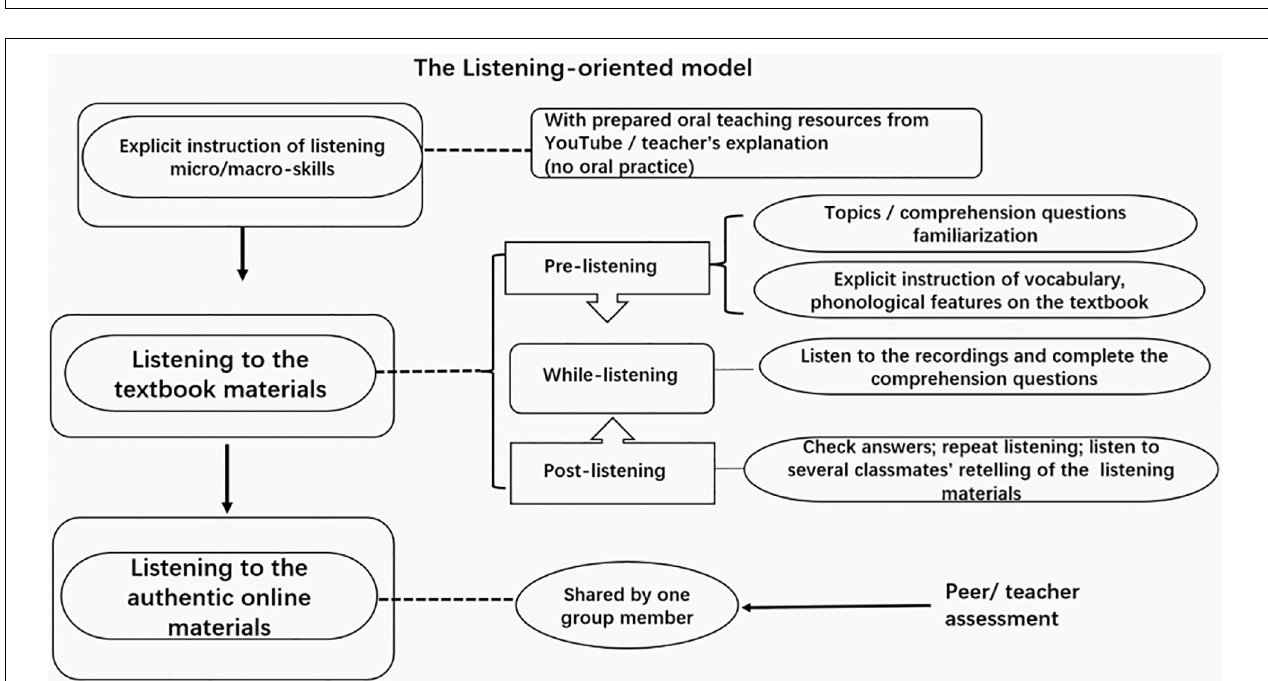
FIGURE 2 | Illustrations for the listening-oriented